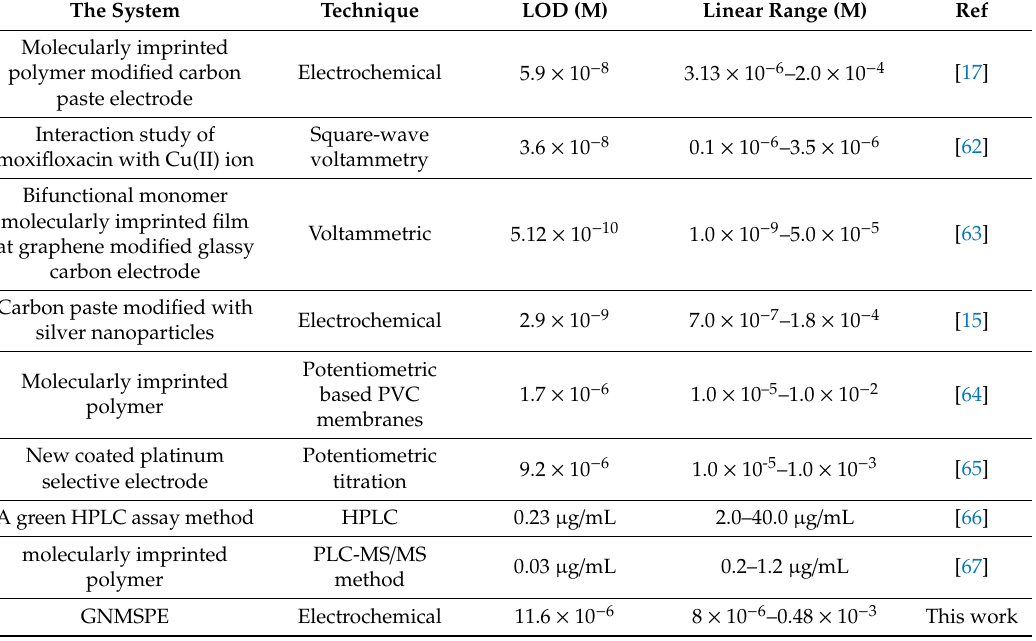
Figure 5. Calibration plot for Moxi, Inset: corresponding di ff erential pulse voltammetry’s (DPVs) for successive addition of Moxi in B-R bu ff er solution of pH 7.0 at scan rate = 10 mV s − 1 using GNMSPE and illustrative picture of a typical SPE used in this work. Table 1. Comparison of the analytical figures of merit for the present method with others approaches for the determination of